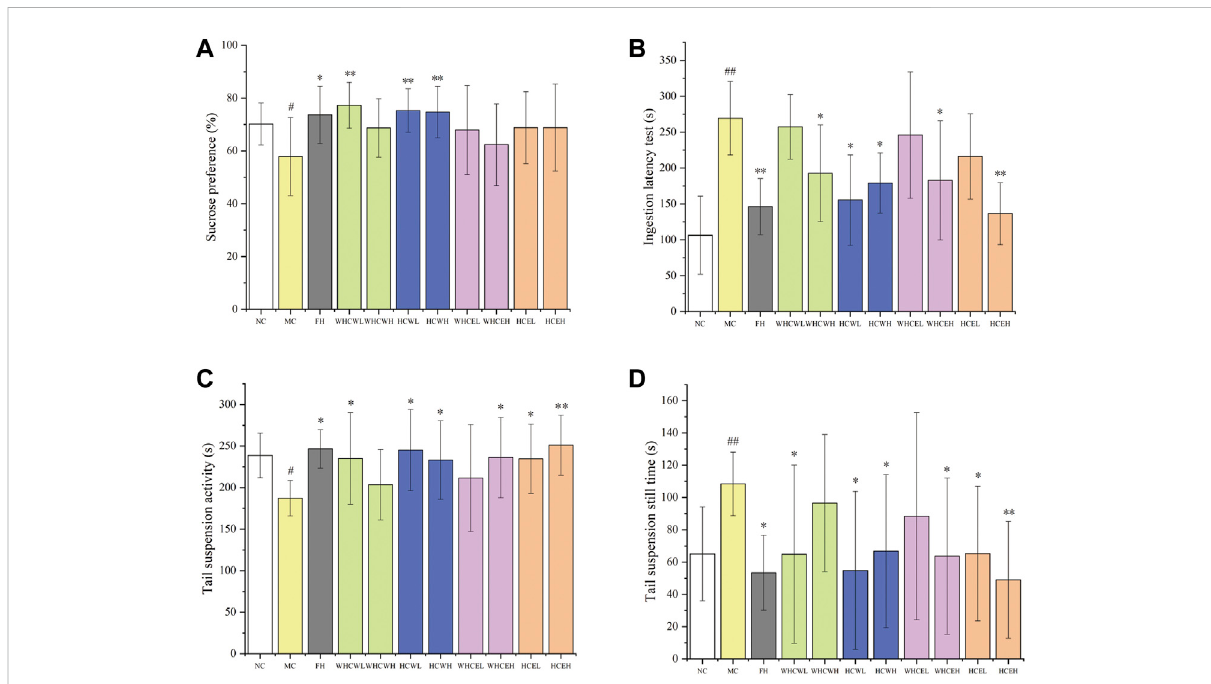
Theeffectsofdifferentdoseextractsof H.citrina fl owersandfresh fl owerbudsonthebehaviorsofCUMSmice. (A) Sucrosepreferencetest, (B) ingestion latency test, (C) tail suspension activity test, and (D) tail suspension still time test. Data are reported as mean ± SD. For statistical signi fi cant, # p < 0.05, ## p < 0.01comparedwiththenormalcontrolgroup;* p < 0.05,** p < 0.01comparedwiththemodelcontrolgroup.NC,normalgroup;MC, modelgroup;FH,Fluoxetinehydrochloridegroup;WHCWLandWHCWH,lowandhigh-doseofwaterextractsoffresh fl owerbuds;HCWLand HCWH,lowandhigh-dose ofwater extractsof fl owers;WHCELandWHCEH,lowandhigh-doseof80%ethanolextractsoffresh fl owerbuds;HCEL and HCEH, low and high-dose of 80% ethanol extracts of fl owers; low-dose: 200 mg/kg; high-dose, 500